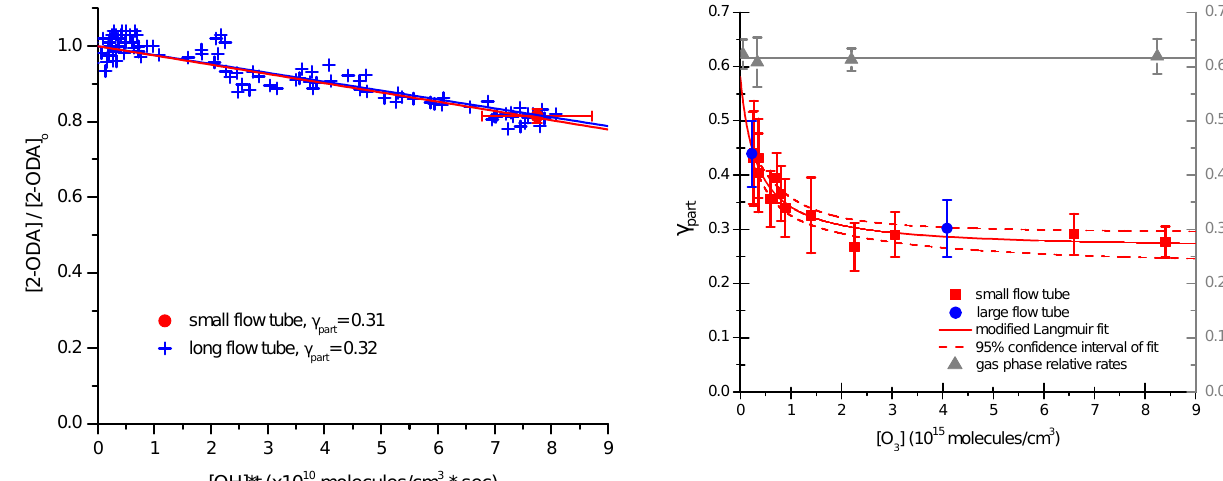
Fig. 5. Effective reactive uptake coefficient, γ part , of OH on 2- ODA particles as a function of O 3 concentration. The Langmuir- type adsorption isotherm used to fit the data, Eq. (4), is also shown with 95% confidence intervals. The best fit parameters are: γ o = 0 . 56 ( ± 0.07), K = 2 . 60 ( ± 1.40) × 10 − 15 cm 3 molecule − 1 , and f = 1 . 86 ( ± 0.16). Also shown are the results of a gas-phase relative rates experiment in which the ratio of the rate constants of 1-butanol and 2-hexanol reacting with OH was determined as a function of [O 3